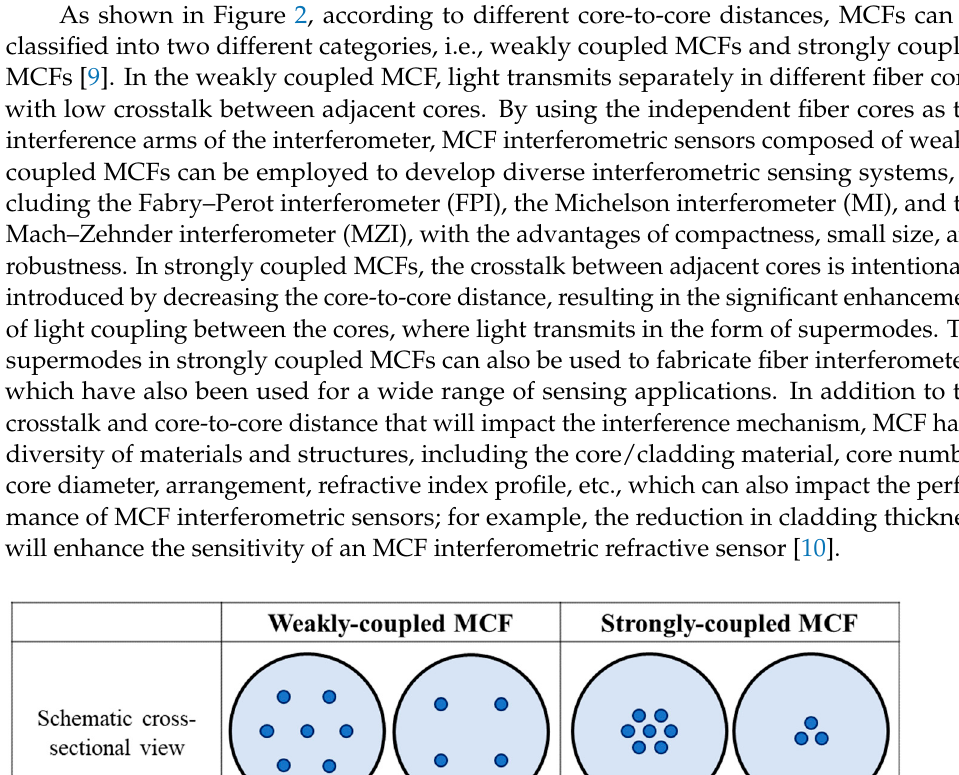
Figure 1. Cross ‐ sectional view of several MCFs. ( a ) Asymmetrical dual ‐ core fiber [5], ( b ) V ‐ type three ‐ core fiber [6], ( c ) weakly coupled seven ‐ core fiber [7].